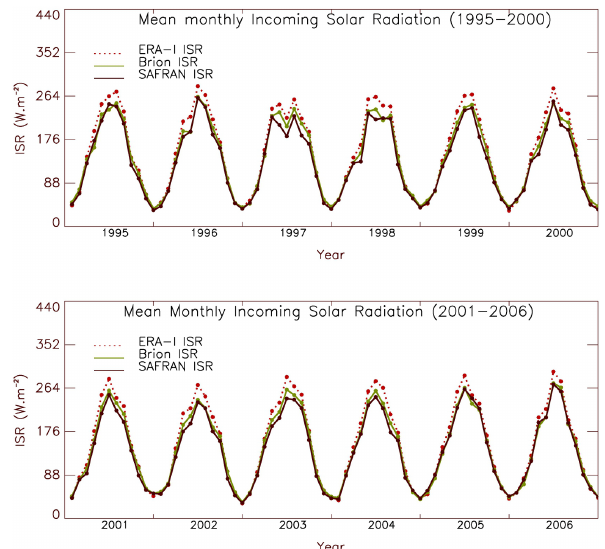
Fig. 7. Mean daily ISR over part of France where there are Brion data (235 grid cells) for SAFRAN, ERA-I and Brion: from (top) January to June 2001, and from (bottom) July to December 2001.